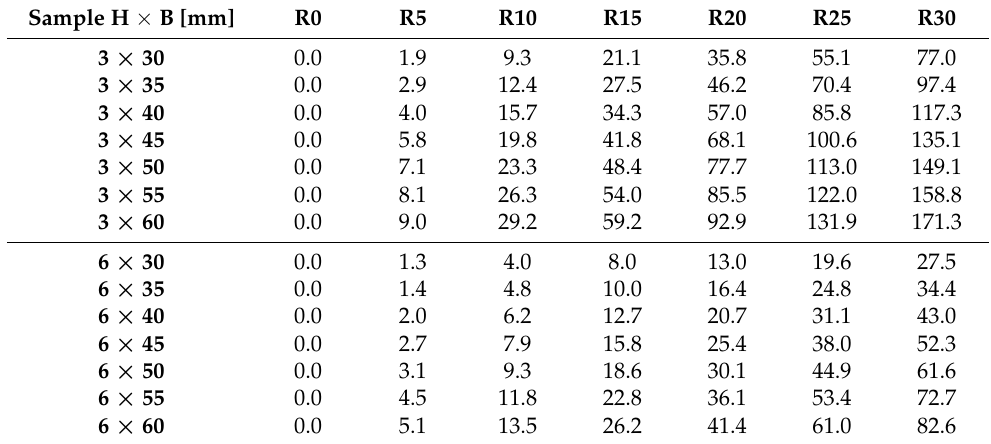
Table 2. Numerical simulation. Summary of the percentage value of the K stiffness increase index, depending on the test package (H × B) and expansion R